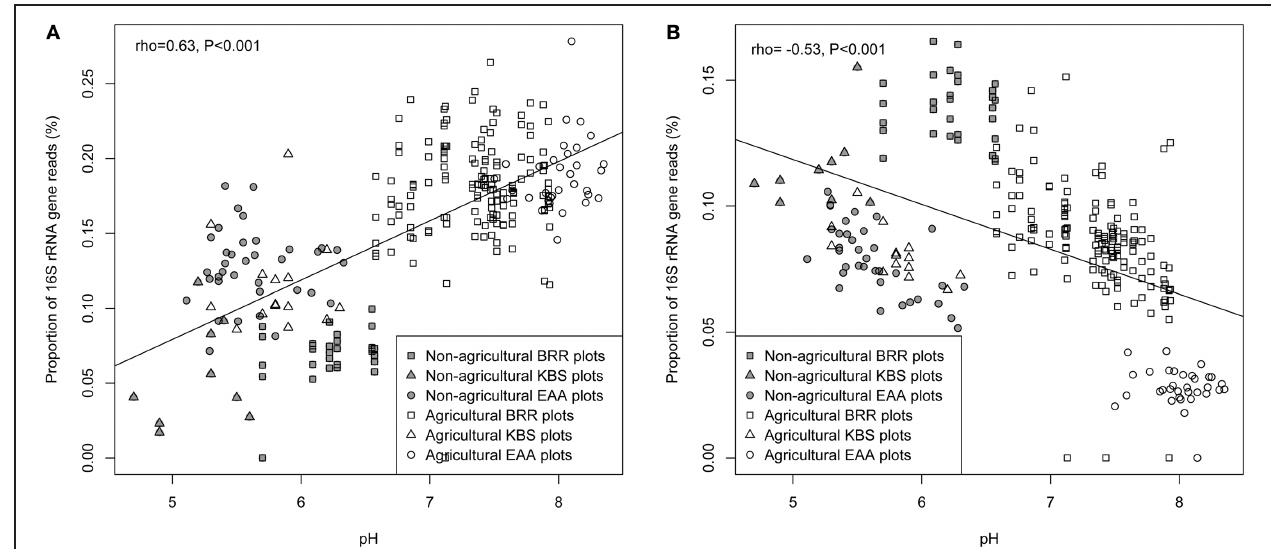
FIGURE 7 | Relationship between the proportion of Ca. Nitrososphaera 16S rRNA gene reads (%) and pH (A); Bradyrhizobium and pH (B) at three experimental sites. Proportion of 16S rRNA reads was normalized by arcsine square